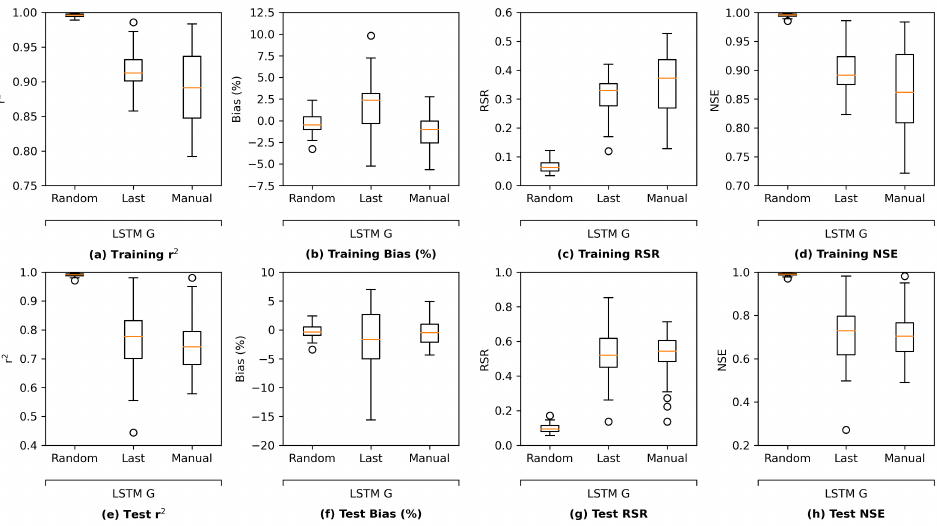
Figure 16. Training and test metrics of the grouped LSTM model under three data-split